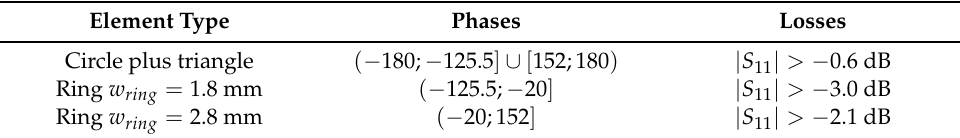
Table 1. Range of phases covered by each element and its associated losses.